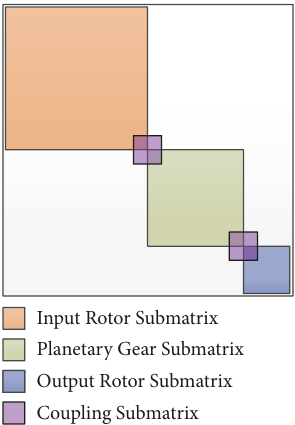
Figure 7: Assembly of the overall stiffness matrix of the gear rotor